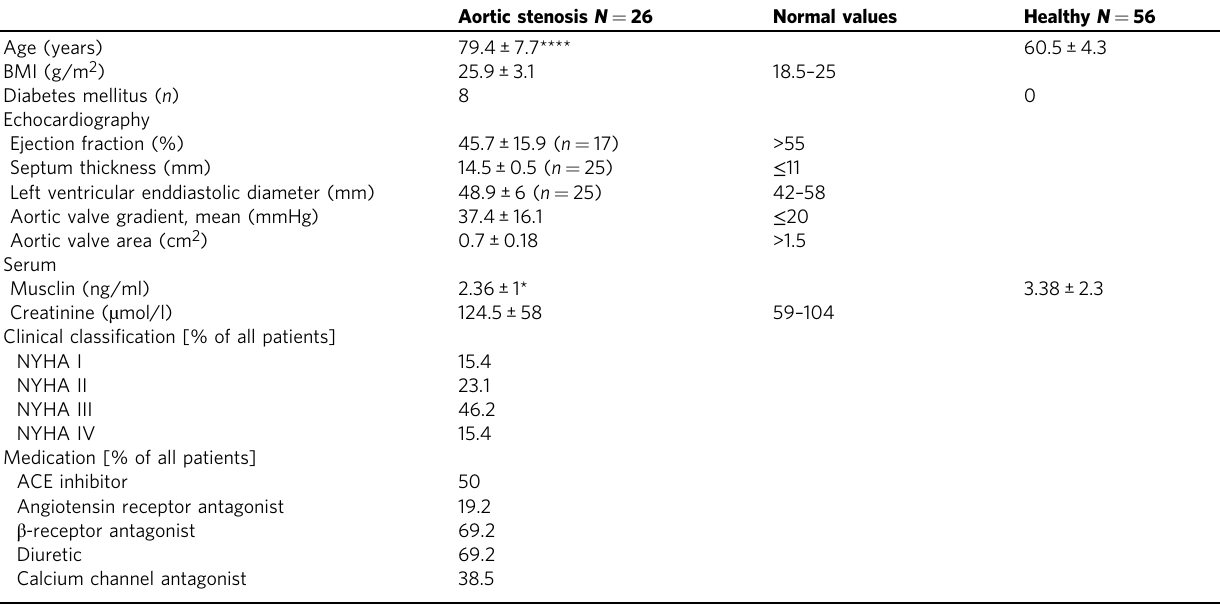
Table 2 Clinical characteristics of the patients (all male) with aortic